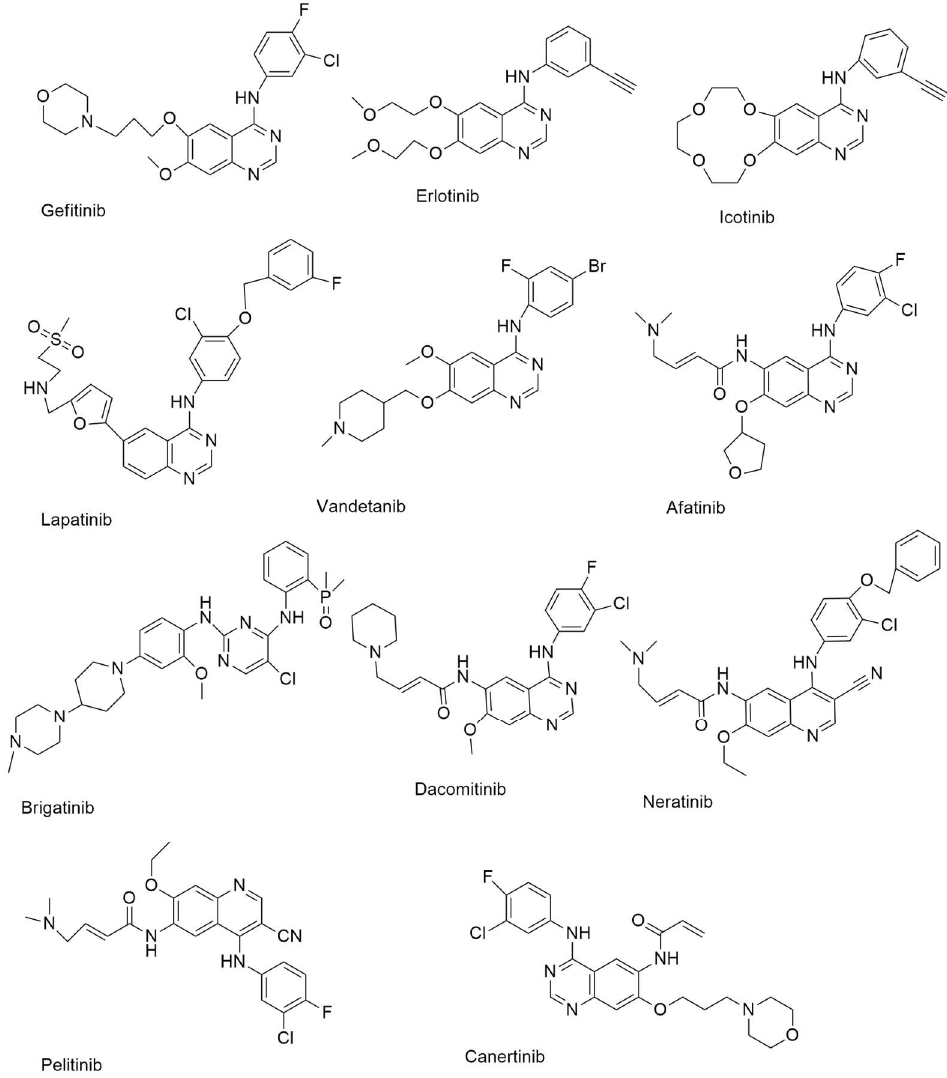
Figure 1. First-generation and second-generation small molecule EGFR-TKIs.